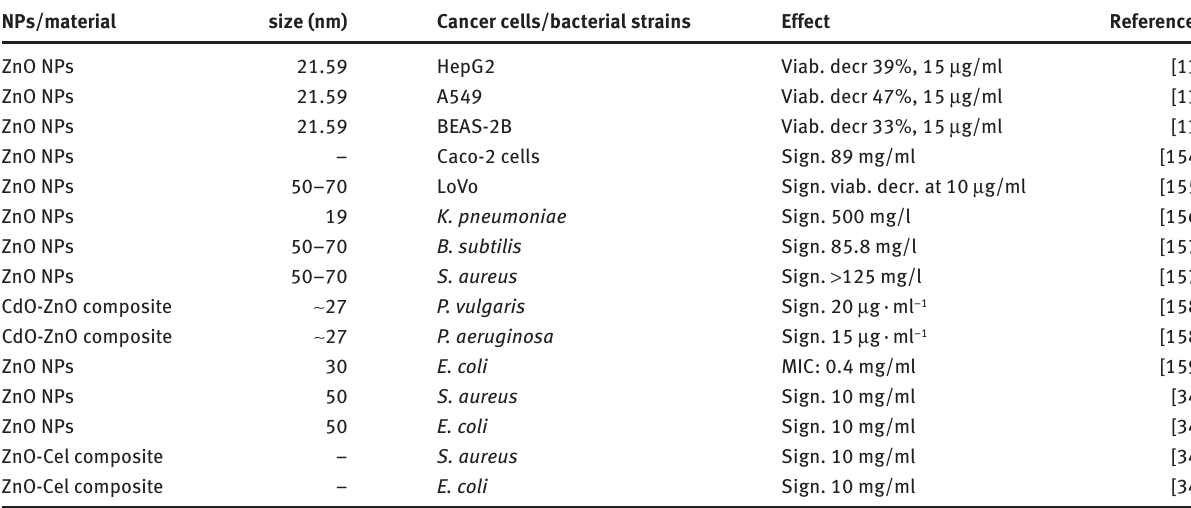
Table 6: Anticancer and antibacterial activities of the ZnO NPs and composites.